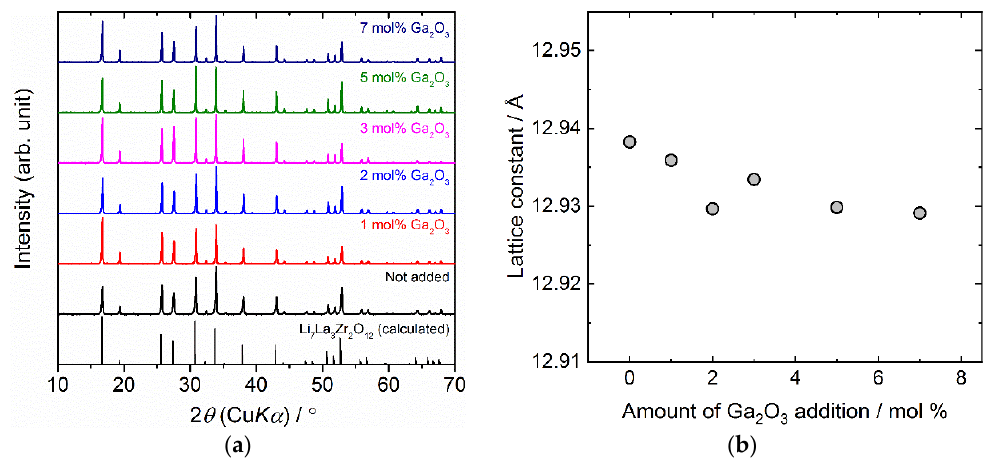
Figure 1. ( a ) X-ray diffraction patterns for sintered Ta-doped LLZO with or without Ga 2 O 3 addition. ( b ) Calculated lattice constant for Ta-doped LLZO is plotted as a function of the amount of Ga 2 O 3 addition. Enlarged data at 2 θ = 24 – 36° and 24 – 56° are shown in ( b ). Calculated pattern for LLZO is also plotted in ( a ) as the reference.